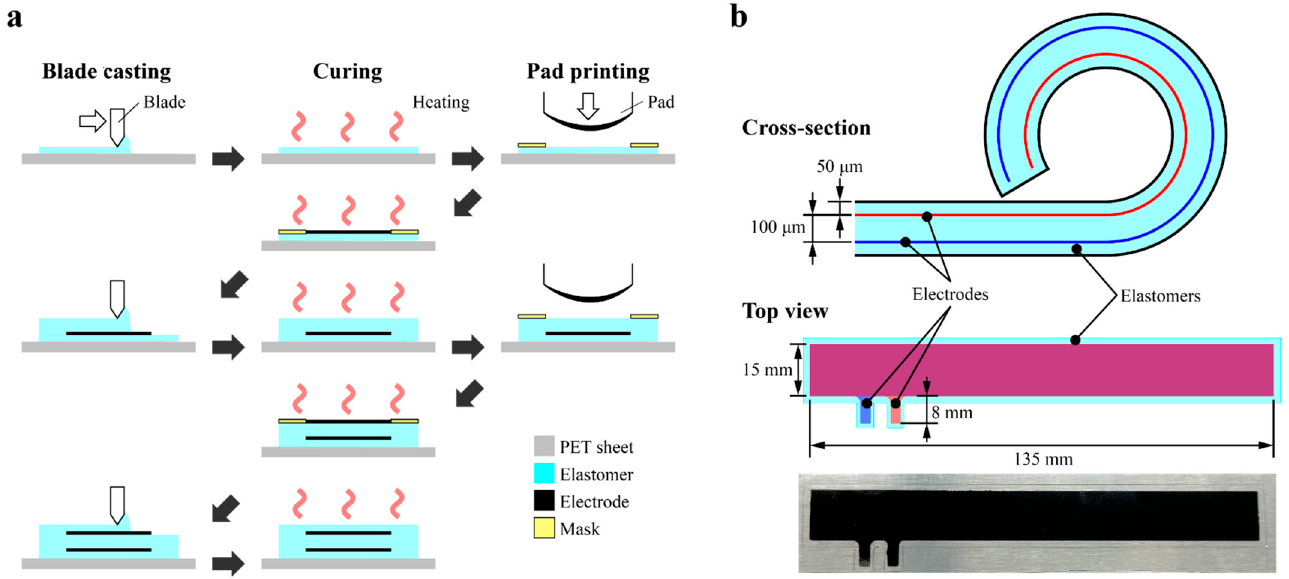
Figure 4. ( a ) Fabrication process of the actuator. ( b ) Structure and dimensions of the DEA part before rolling.